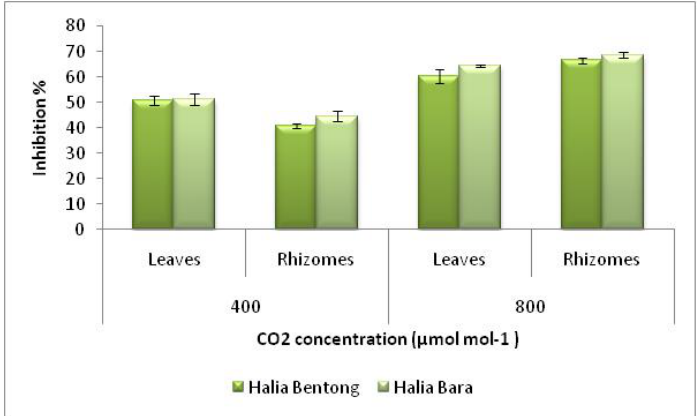
Figure 3. DPPH scavenging activities of the methanolic extracts in different parts of two varieties of Zingiber officinale (error bar represents standard deviation )